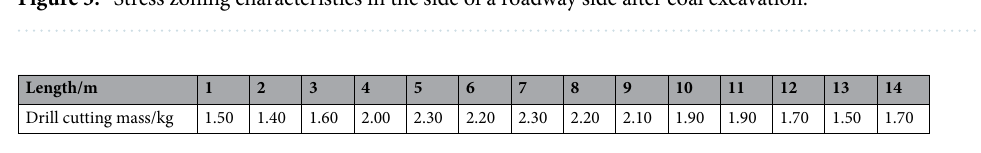
Table 1. The testing results of drill cutting